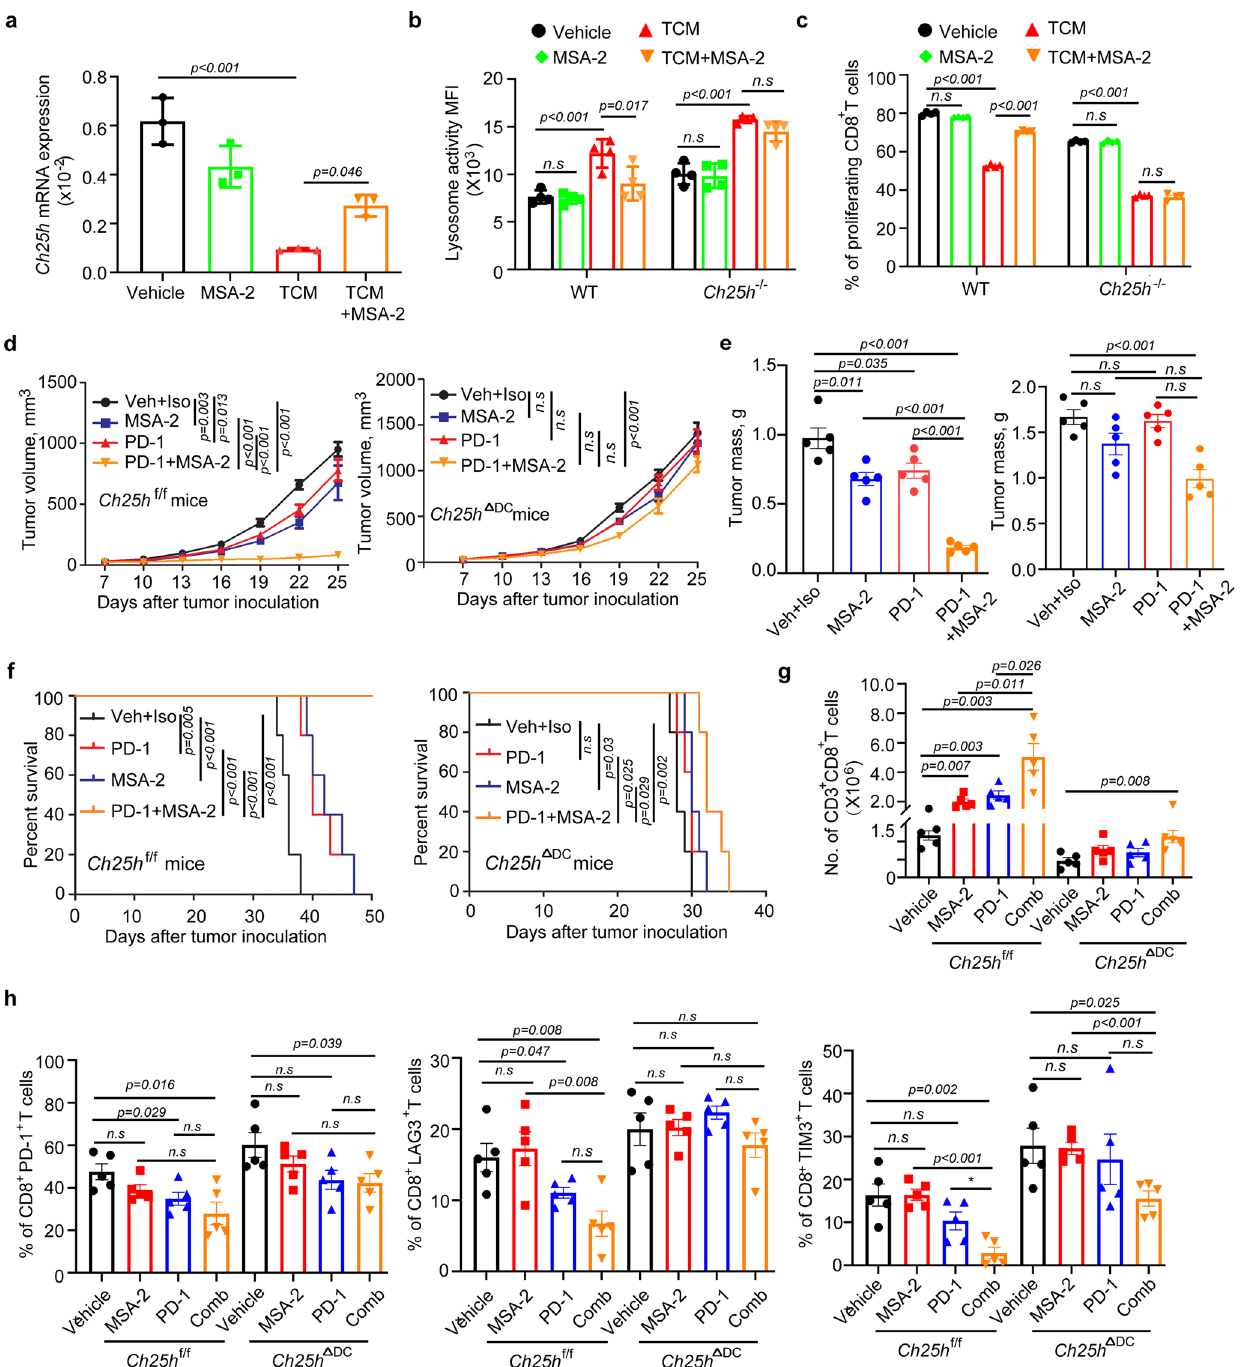
Fig. 7 | STING agonist acts to maintain CH25H expression in DCs to increase intratumoral immune in fi ltration and elicit anti-tumor therapeutic effects. a qPCR analysis of Ch25h mRNA in BMDCs pre-treated with MSA-2 (10 µ M) for 30min and LLC-conditioned media (TCM, 67%, v/v ) for 2h. n =3 biologically independent samples. b Quantitative estimates of lysosome activity in WT or Ch25h − / − BMDCs pretreated with LLC-conditioned media (TCM, 70% v/v) with or without pre-treatment of MSA-2 (10 µ M, 2h pretreatment) for 16h. n =4 biologi- cally independent samples. c Antigen cross-presentation was assessed by pro- liferation of CFSE-labeled OT-I T cells co-cultured (10:1) with OVA-pulsed (200 μ g/mL, 6h) WT or Ch25h − / − DCs for 72h. DCs were pre-treated with medium conditionedbyLLCcells(70%,v/v)for20hwithorwithoutthetreatmentofMSA-2 (10 µ M) for 16h before OVA pulse. n =4 mice per group. d Volumes of LLC tumors grown in Ch25h f/f (toppanel) or Ch25h Δ DC (bottom panel) micetreatedwith Vehicle